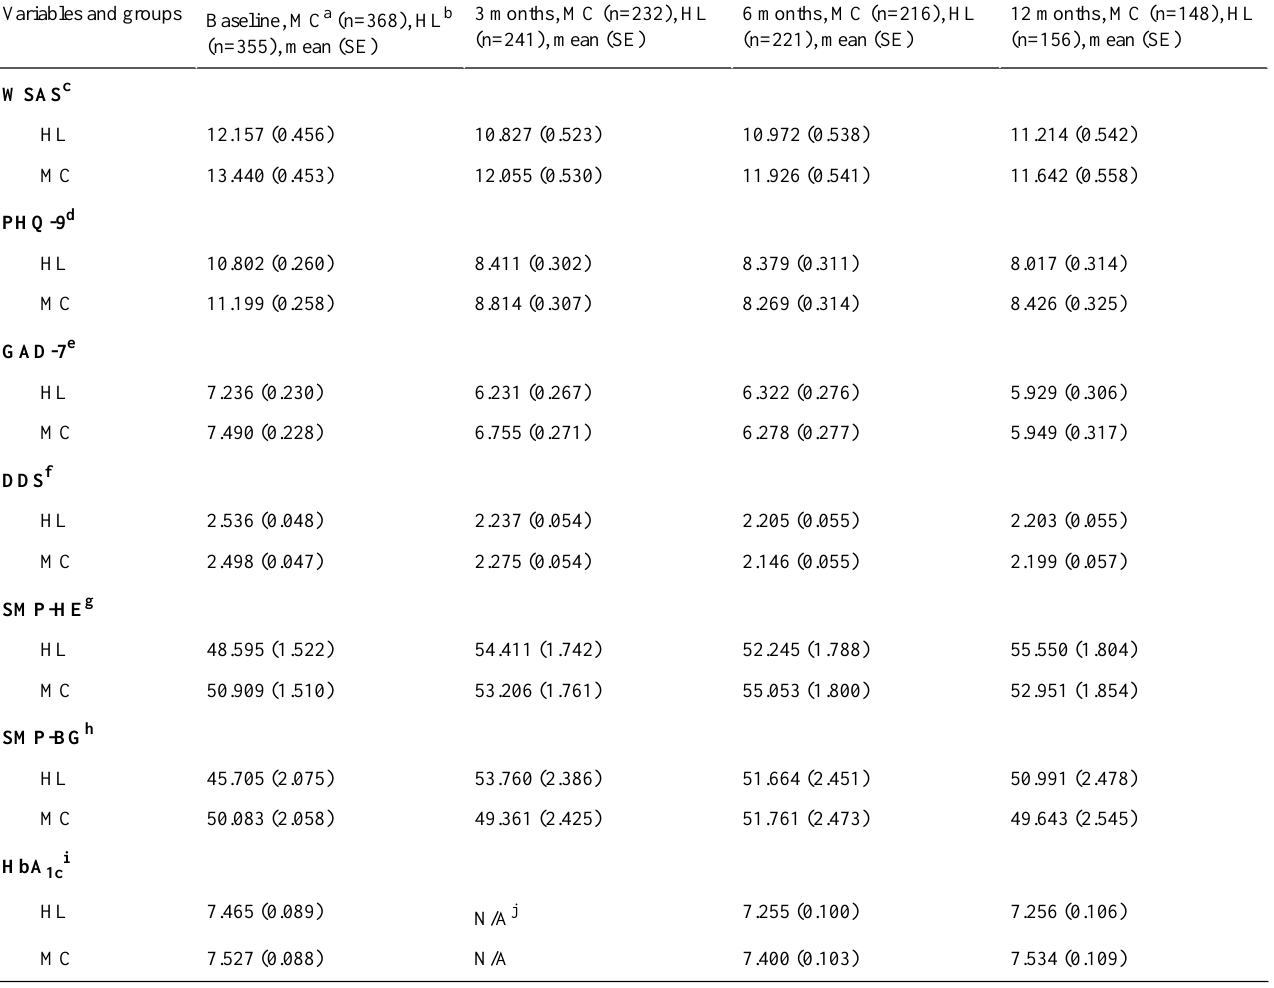
Table 3. Estimated marginal means and SEs on key outcome variables for the myCompass and Healthy Lifestyle groups.